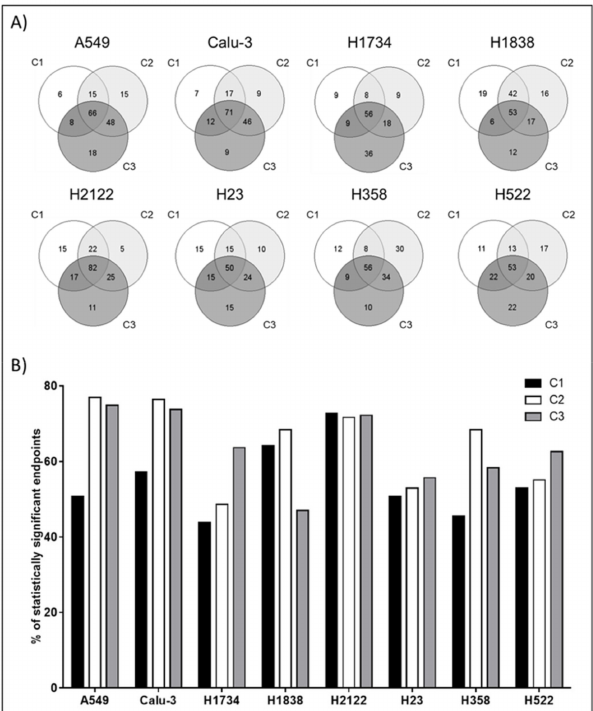
Figure 3. For each cell line and DMSO concentration (C1 = 0.0008%, C2 = 0.002% and C3 = 0.004%, respectively), a two-tailed Kruskal Wallis rank test was performed to capture changes in protein ex- pression/activation across timepoint. Technical replicates ( n = 3) were collected for each observation. Number and percentage of proteins that reached statistical significance in each DMSO concentration are reported. Venn diagrams illustrate unique and shared proteins across DMSO concentrations that reached statistical significance within each cell line (Panel A ). Bar graphs show the percentage of proteins and phosphoproteins that were statistically different in each cell line and at each DMSO concentration (Panel B